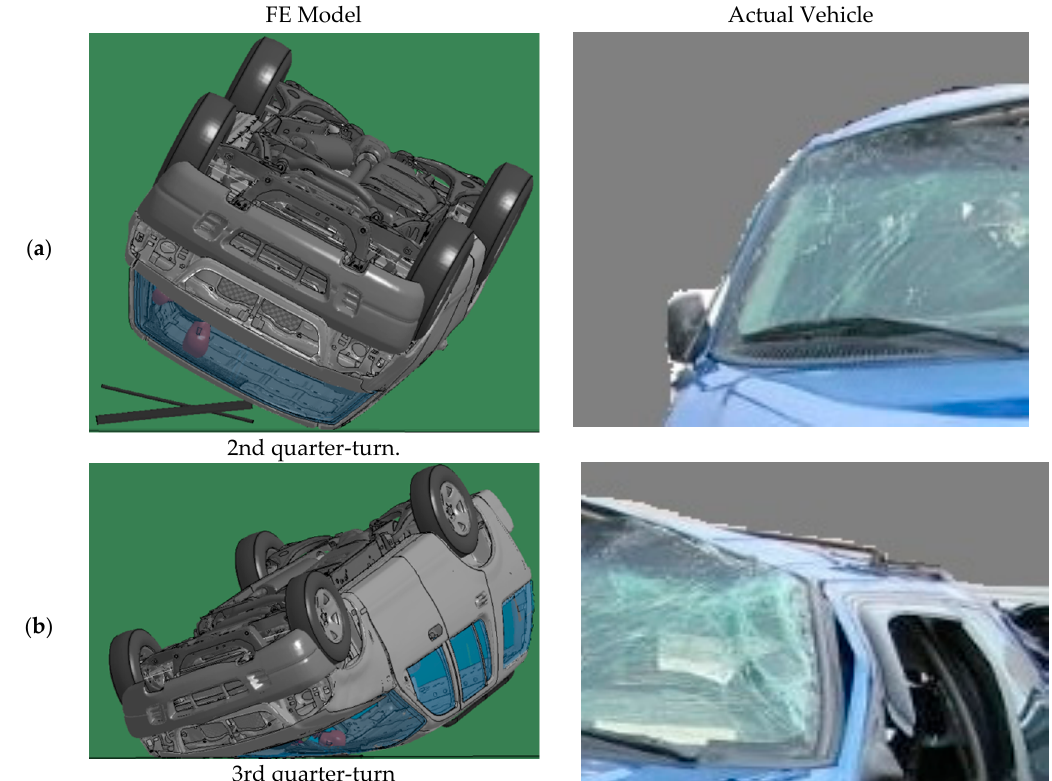
Figure 4. Finite element (FE) vehicle model during key ground impacts ( left ) with corresponding vehicle damage ( right ).